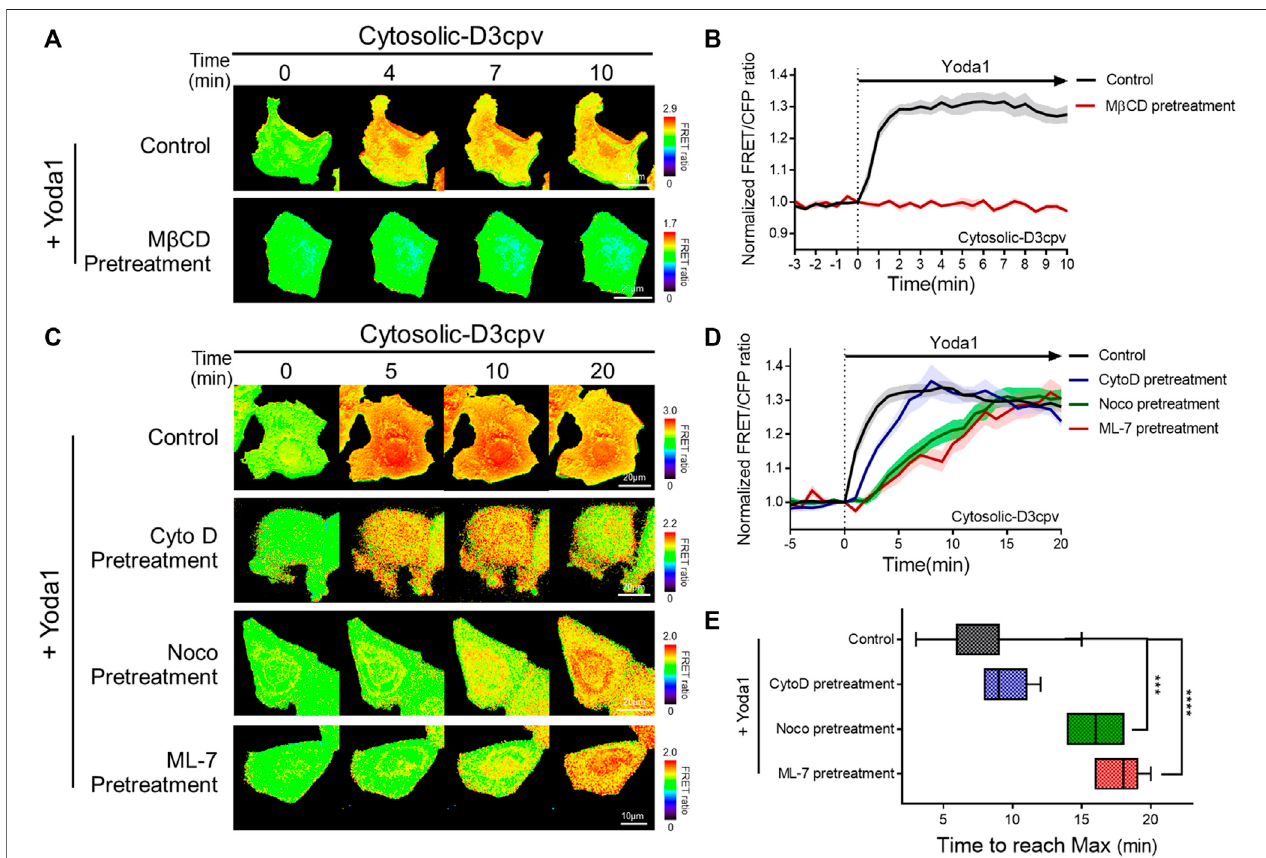
FIGURE 5 | Intactness of cholesterol, microtubules, and actomyosin structures plays an important role in the normal function of Piezo1. (A,C) Time-lapse FRET images of the cytosolic-D3cpv in untreated MCF-7 cells and cells pretreated with (A) M β CD, (C) cytochalasin D (CytoD), nocodazole (Noco), and ML-7. All cells were exposed to Yoda1 (1 μ M) dissolved in CO 2 -independent culture medium. The color scale bars represent the range of the FRET/CFP emission ratio detected using the biosensor.HotandcoldcolorsindicatehighandlowCa 2+ concentrations,respectively. (B,D) ThetimecoursesrepresenttheaverageofthenormalizedFRET/CFP emission ratio changes of the cytosolic-D3cpv in (B) M β CD, (D) CytoD, Noco, and ML-7 pretreatment groups. The lines are mean values of normalized emission ratios, withdiluted colorsindicatingthe S.E.M ( n =7). (E) Thebox plotsdescribe thetime taken toreach themaximum valueofthe FRET/CFP ratiointhe control, CytoD, Noco, and ML-7 pretreatment groups with whiskers representing minimum and maximum values, respectively. ( n = 7, *** p < 0.001 and **** p < 0.0001, Student t -test).